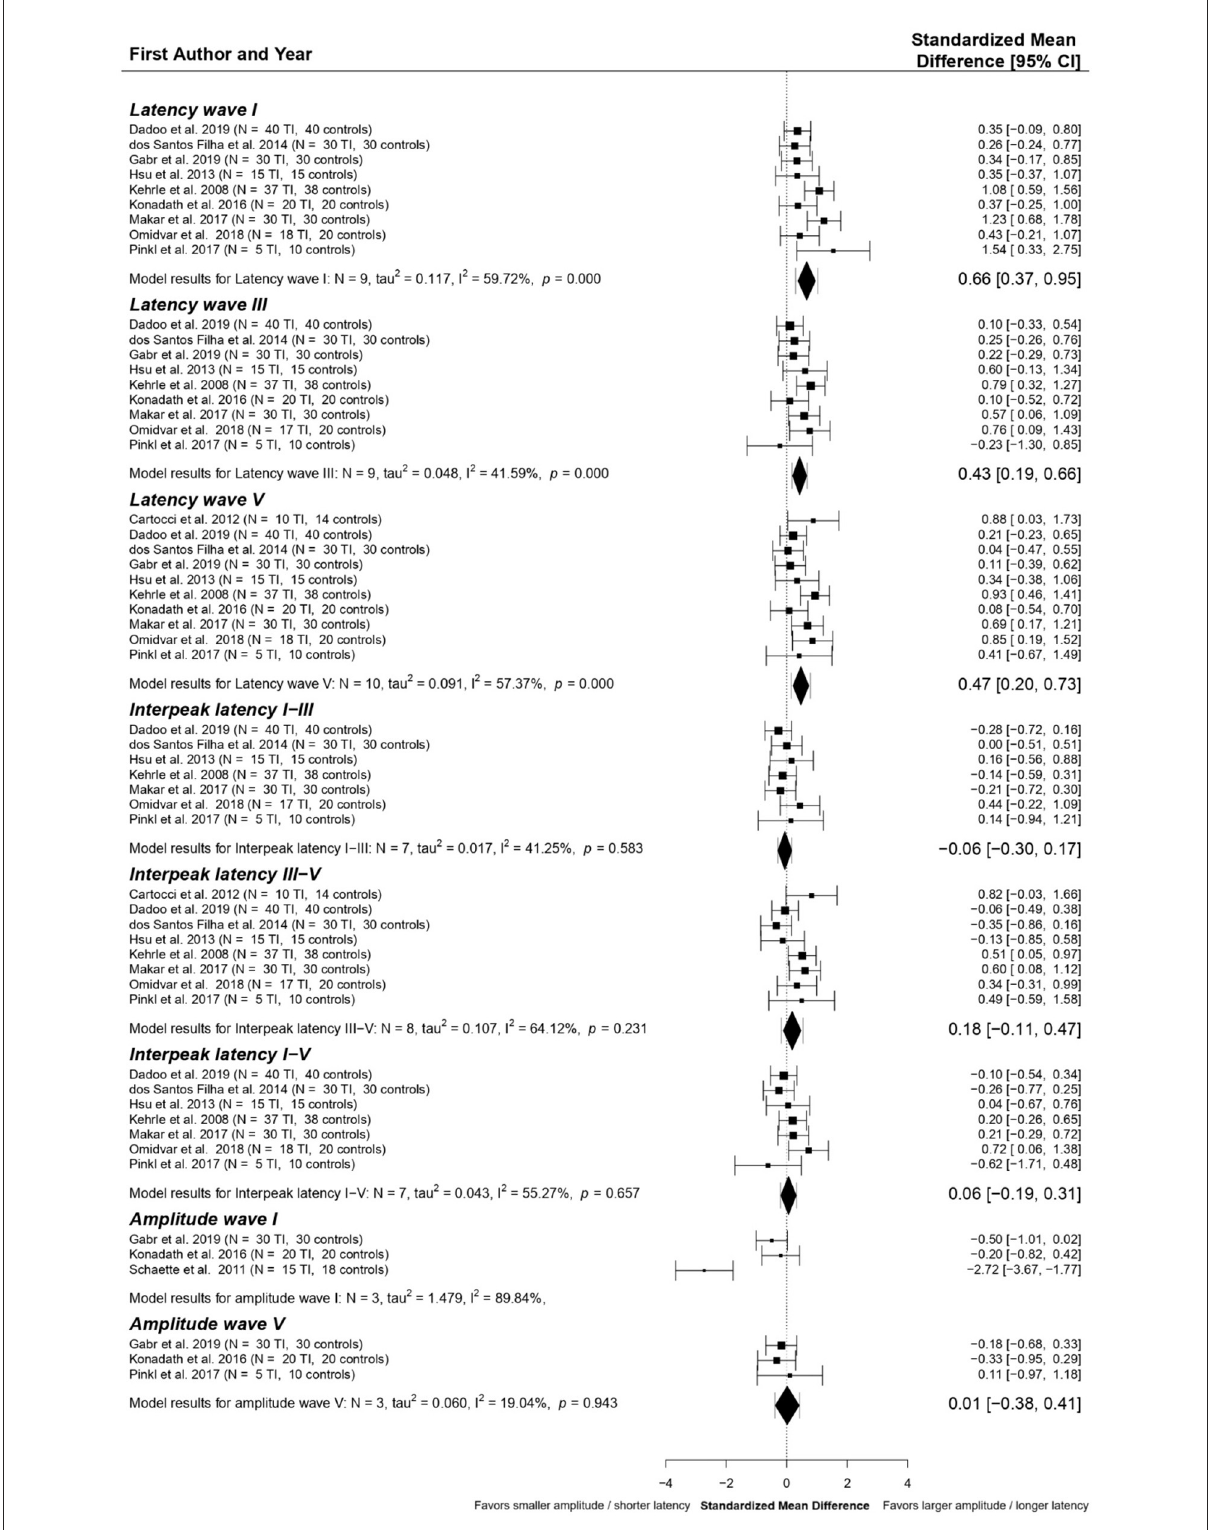
FIGURE4 Forest plot of the primary multivariate analysis of ABR components in studies comparing tinnitus patients without hearing loss to controls. Results are grouped according to ABR component. Results from individual papers are presented as Standardized Mean Differences (SMD) ± 95% confidence intervals. Overall results from the primary meta-analytic model are given for each component. SMD with 95% confidence intervals are represented by diamonds, while error bars correspond to credibility/prediction intervals, defined as the intervals where ∼ 95% of the true outcomes are expected to